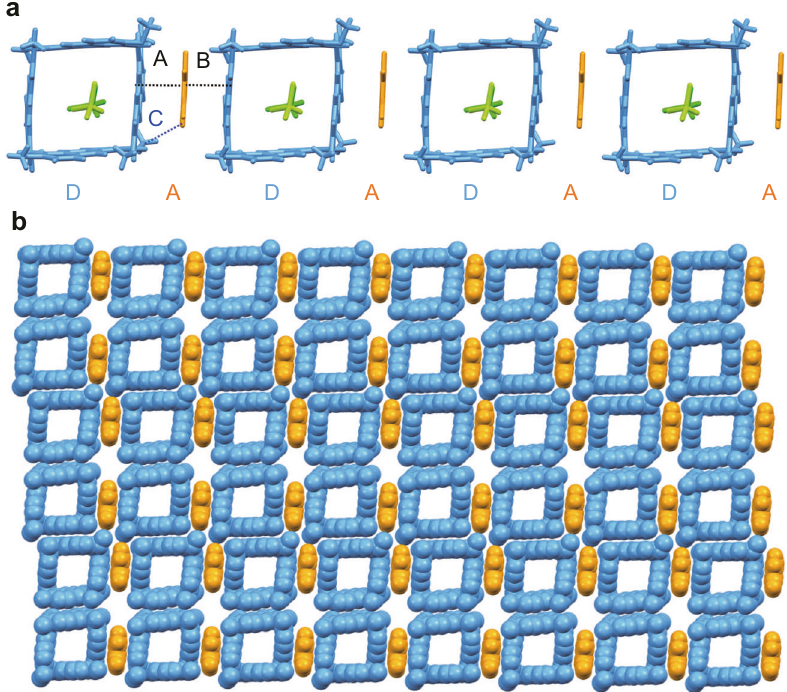
Fig. 7 Supramolecular tessellations of P4 with TFTN in chloroform system. Crystal structure of P4-TFTN a showing a the linear DADA-like supramolecular structure in the horizontal direction and b 2D layer-like network superstructure. Different colors represent the symmetry